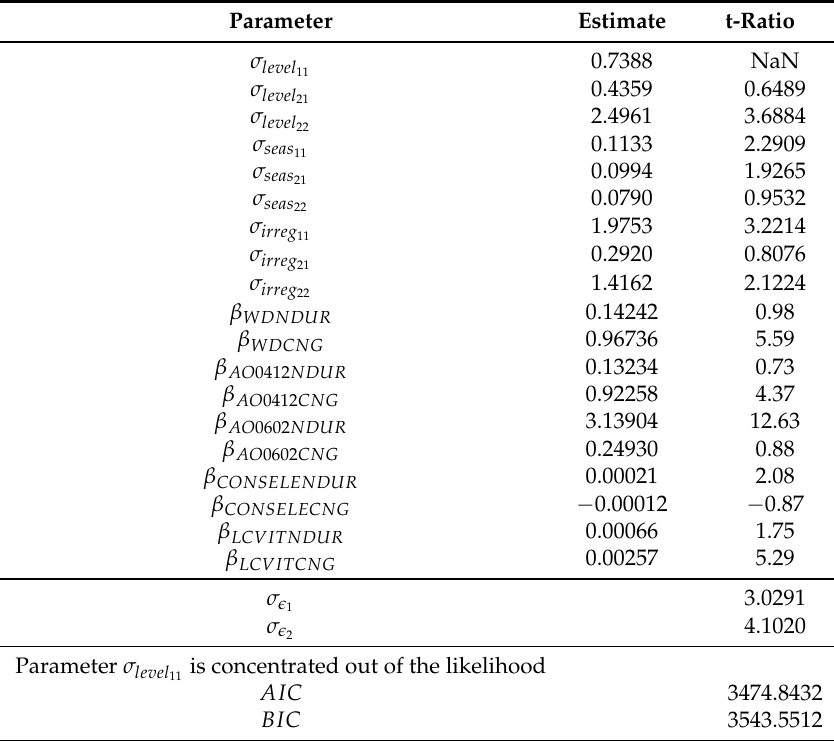
Table A15. Endogenous variables: IPI t non-durable goods, CNG t